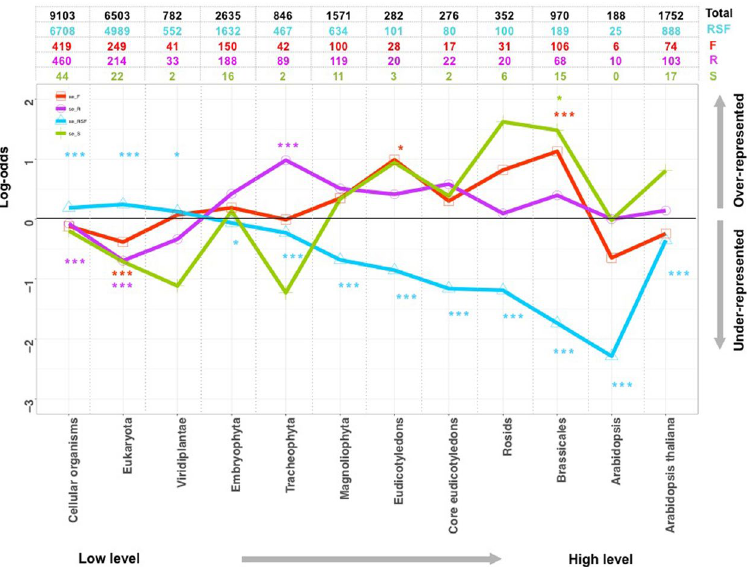
Figure 4. Enrichment analysis of organ-specific sense-expressed genes in different phylostrata. RSF: genes with expression shared by Root, Seedling and Flower; S: Seedling-specific expressed genes; R: Root-specific expressed genes; F: Flower-specific expressed genes; Total: all the protein coding genes with an assigned phylostratum. Gray line: A log-odds of zero, which corresponds to the actual number of organ-specific genes in each phylostratum equaling the predicted number. Because there are zero S genes from phylostratum Arabidopsis , the log-odds value is undefined here. In plotting the figure, we conservatively adjusted the observed count to one and re-calculated the log-odds value. ( * p-value < 0.05, ** p-value < 0.01 and *** p-value <